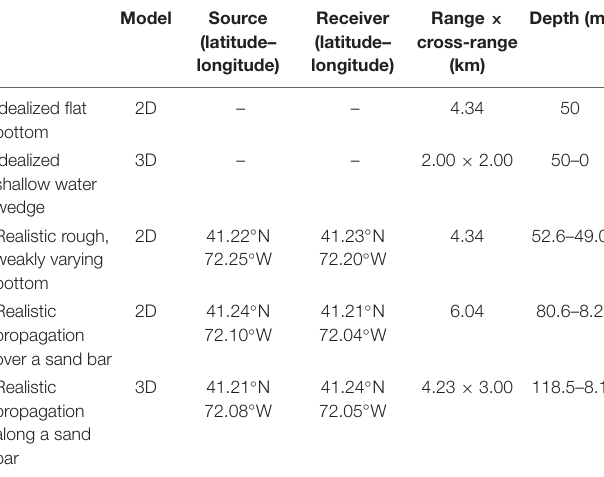
TABLE 1 | Summary of scenarios considered in underwater sound propagation